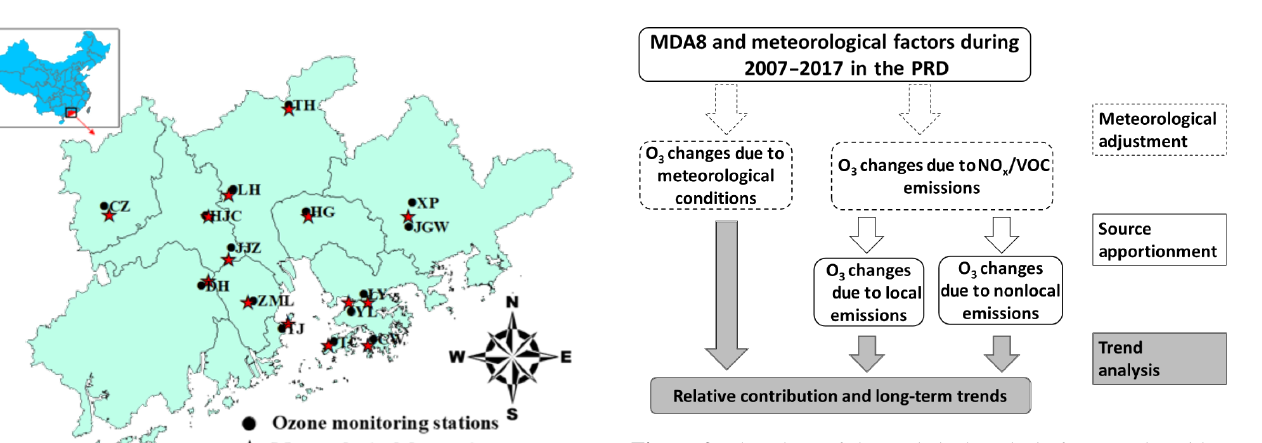
Figure 2. Flowchart of the statistical analysis framework to iden- tify the long-term impacts of meteorology and local and nonlocal emissions on ambient